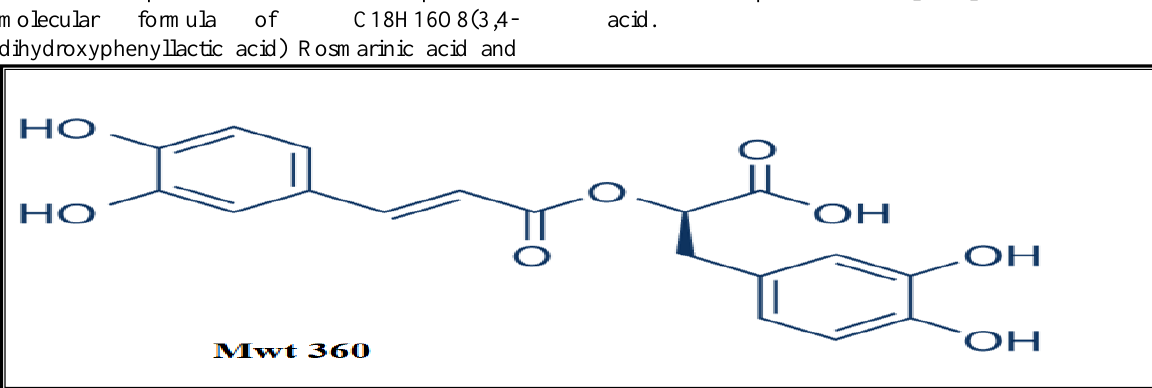
Figure 21. Chemical structure of Rosmarinic acide with molecular weight 360.31 Gram/mol